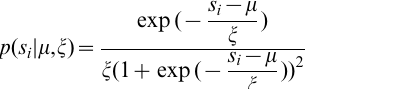
Figure S1 Results of the goodness of fit test for ILD distributions. Curves plot p-values of the Kolmogorov-Smirnov test. The purpose of the test was to compare empirical ILD distributions at each frequency with the logistic distribution. The null hypothesis was that both distributions are equal. Black dots mark frequency channels, where one of the p-values was below 0 : 01 . As visible on the plot in all except 4 cases (across all scenes and frequencies), the test did not allow for rejection of the null hypothesis at 0 : 01 confidence level. Figure S2 Spectrotemporal representation of indepen- dent components. Panels in the left and right columns correspond to the left and the right ear IC parts respectively. Rows correspond to auditory scenes. To obtain a time-frequency representation, Wigner-Ville distributions were computed for each monaural part of each IC. This transformation localizes energy of a temporal waveform on a time-frequency plane. Each component is represented by the iso-probability contour of the Wigner-Ville distribution corresponding to 60% of the total energy. Monaural vectors belonging to the same IC are plotted in the same color.